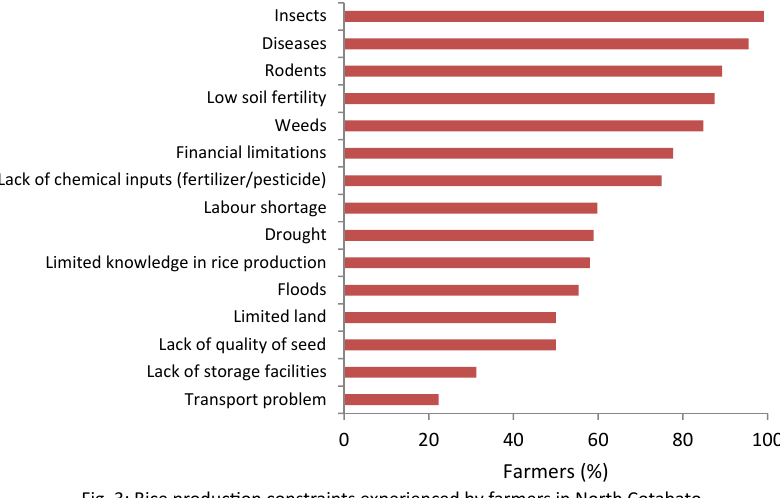
Fig. 3: Rice production constraints experienced by farmers in North Cotabato Table 4: Major insect pests experienced by farmers in rice